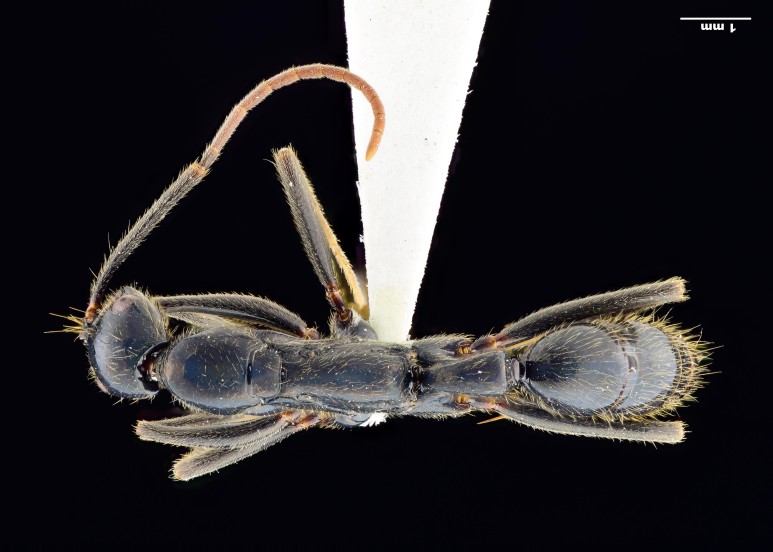
Body, dorsal view